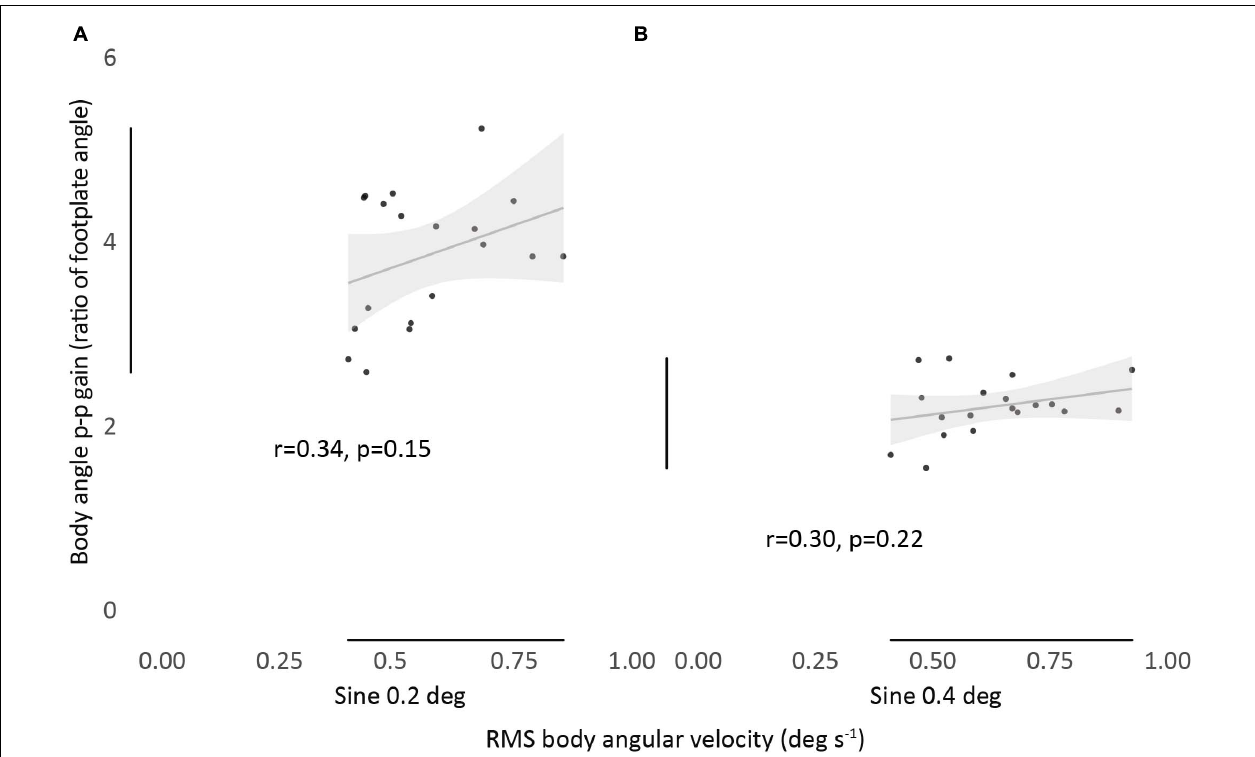
FIGURE 3 | Relationship between RMS body angular velocity and body angle p-p gain in sine 0.2 (A) and sine 0.4 (B) conditions. Bivariate scatter plot with regression line and confidence interval band (95% CI). Pearson’s r and P -values show a non-significant correlation between all